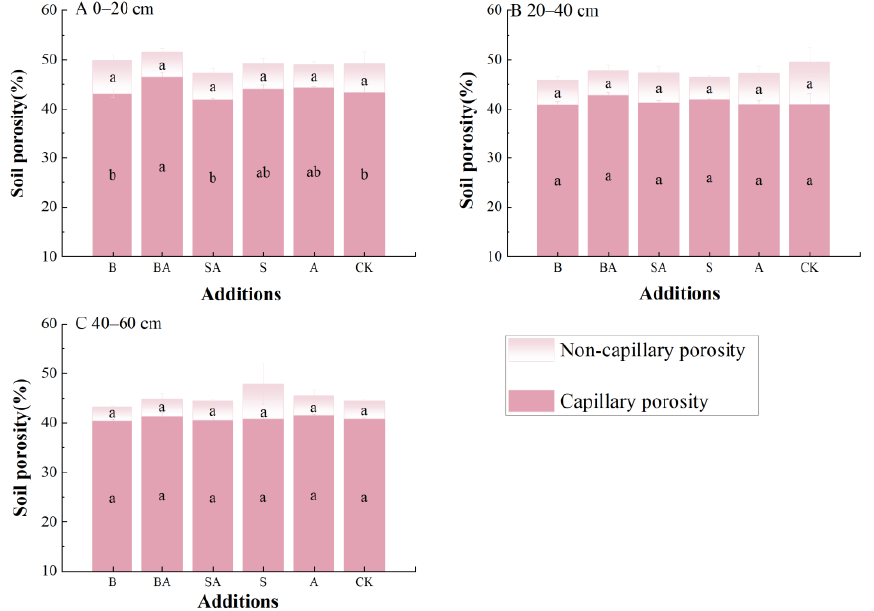
Figure 2. Variations in soil porosity under different treatments. ( A ) Soil porosity in 0–20 cm soil layer; ( B ) soil porosity in 20–40 cm soil layer; ( C ) soil porosity in 40–60 cm soil layer. Different lowercase letters indicate significant differences between various treatments ( p < 0.05). Error bars refer to standard errors.